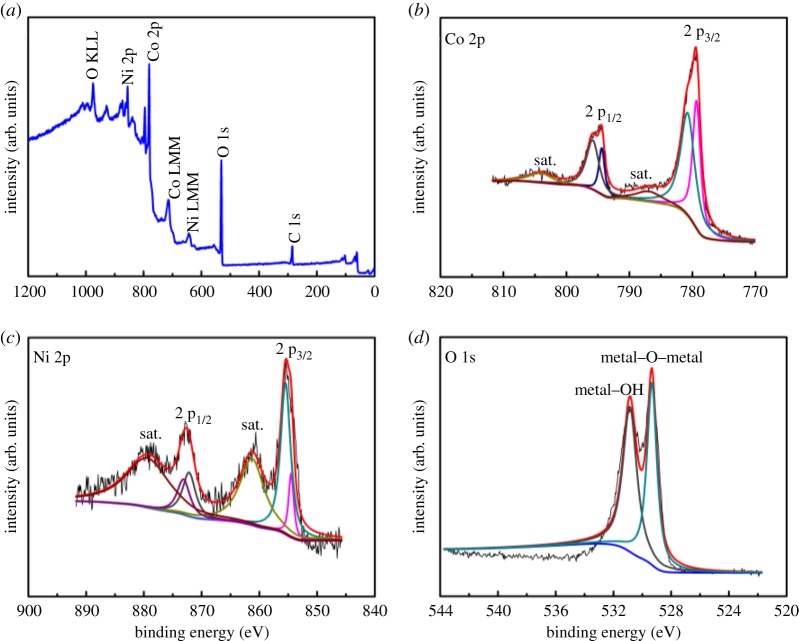
XPS spectra of Co0.75Ni0.25(OH)2: D: (a) wide scan spectrum, and high-resolution XPS spectra of (b) Co 2p, (c) Ni 2p and (d) O 1s regions.